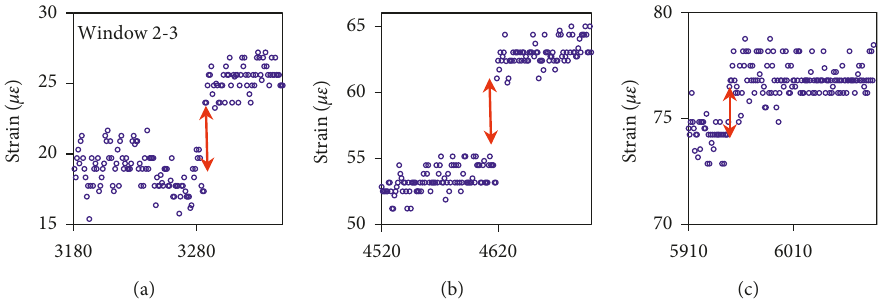
Figure 20: Flame front phase. (a) First step change. (b) Second step change. (c) Third step change. Table 2: Strain amplitude formed by the flame front passing through the FBG sensor in the second test. First step change ( με ) (Figure